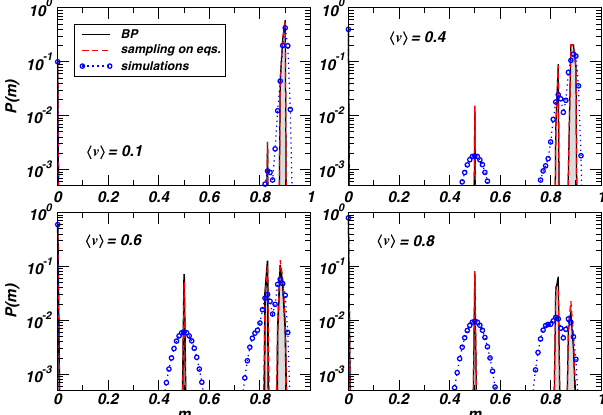
FIG. 8. Distribution P ð m Þ of the probability m that a node is infected in the stationary state of the SIS process on random regular graphs of degree K ¼ 4 for h v i ¼ 0 . 1 , 0.4, 0.6, 0.8. Results are computed using BP by means of Eq. (32) (black solid line) on infinite networks, by sampling solutions of Eq. (7) (red dashed lines), and by means of simulations of the stochastic dynamics, both on a finite network of N ¼ 10 3 nodes and with a sample of 10 4 immunization sets.